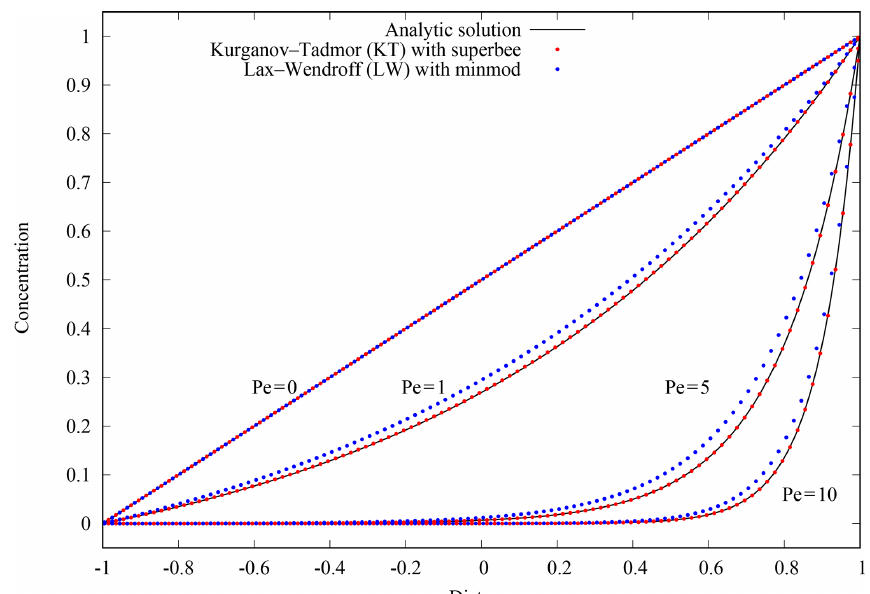
Figure 4. Benchmark 2 results. Steady-state solutions for different Péclet numbers ( Pe ) on a domain x ∈ [− 1 , 1 ] with boundary conditions c = 0 at x = − 1 and c = 1 at x = 1. Black lines show the respective analytic solutions given by Eq. (81). Red and blue dots show, respectively, the KT + RK4 and LW + EU1 numerical solutions. The case of Pe = 0 (pure diffusion problem) has a linear solution and is exactly matched by both schemes. For the rest of the cases, KT + RK4 outperforms LW + EU1. Results use 200 equally spaced grid